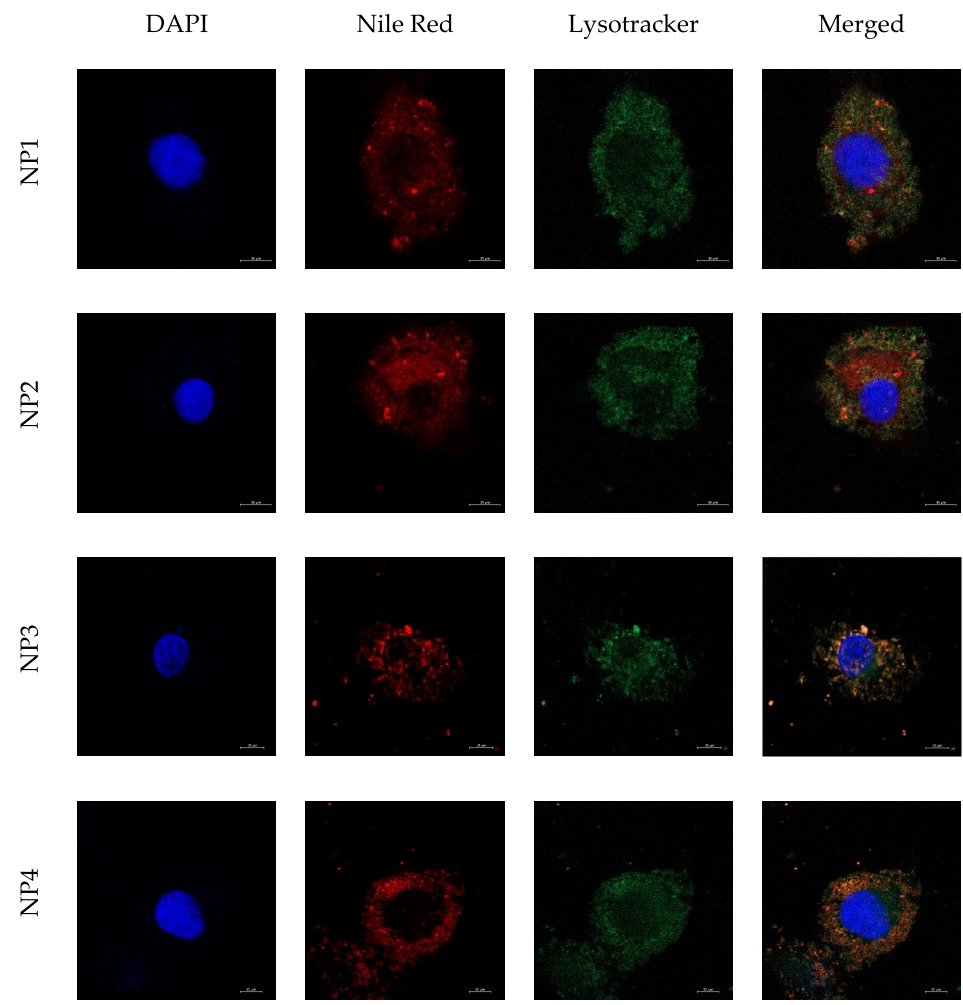
Figure 6. Intracellular uptake of NPs into HeLa cells. Fluorescence indicates nucleus (blue), NPs (red), and lysosomes (green), as observed by confocal microscopy (×64, scale bar= 10 μ m).